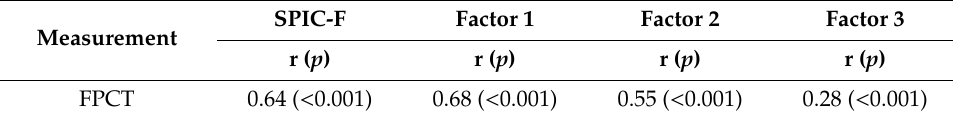
Table 3. Correlation between SPIC-F and Family Perceptions of Care Tool (FPCT). N = 330.